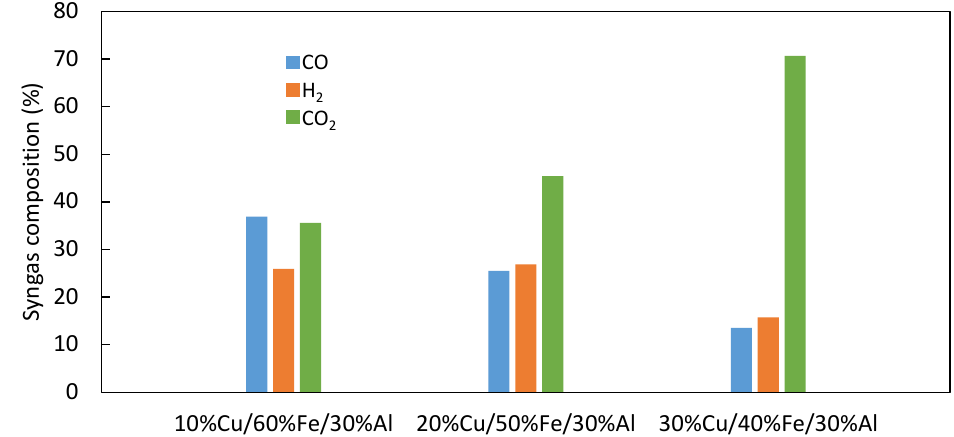
Figure 8. Gasification of biomass with the bimetallic Fe-Cu oxygen carrier with various Cu loadings at a 0.4:1 mass ratio of biomass to oxygen carrier at 800 °C.